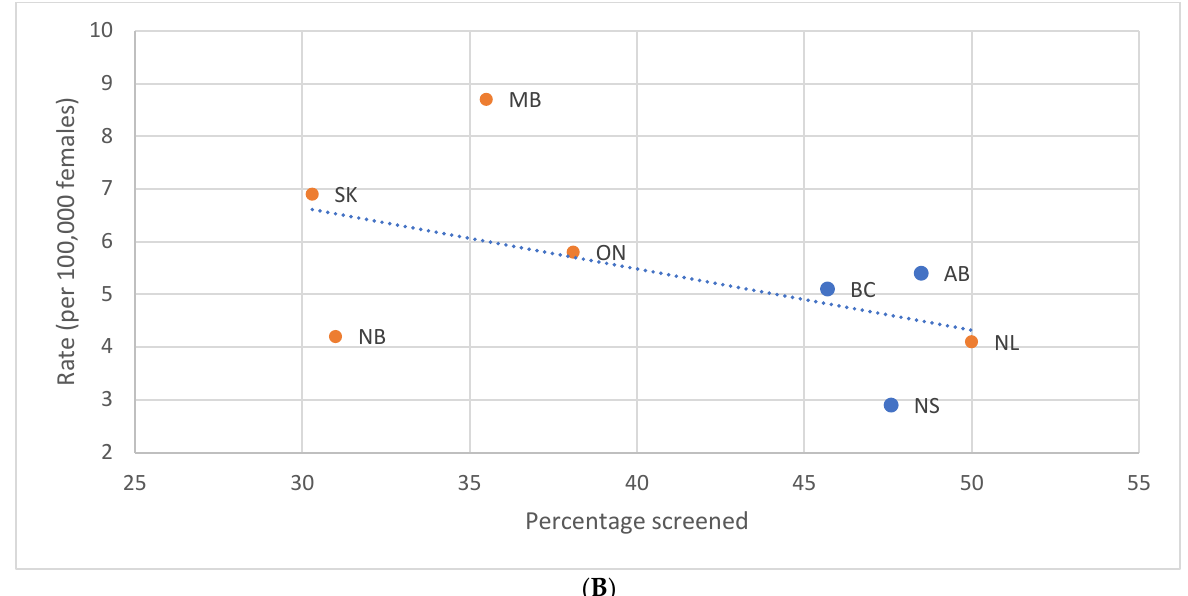
Figure 7. ( A ). Incidence rate of stage I female breast cancer during the 2011 to 2013 period by provincial screening participation rate in 2012, ages 40 to 49 years, selected provinces. ( B ). Incidence rate of stage IV female breast cancer during the 2011 to 2013 period by provincial screening participation rate in 2012, ages 40 to 49 years, selected provinces. Note: Orange dots denote comparators and blue dots denote screeners. Quebec is excluded because cases diagnosed in Quebec from 2011 onward had not been submitted to the Canadian Cancer Registry. The three Canadian territories (Yukon, Northwest Territories, and Nunavut) were excluded from the stage I and IV analyses, and Prince Edward Island from the stage IV analysis, because the number of incident cases was too small to be reliably compared against other jurisdictions. Source: Canadian Cancer Registry (1992 to 2018) and Canadian Community Health Survey [42,44]: Annual Component (2012) at Statistics Canada; provincial and territorial screening practices [49,50].